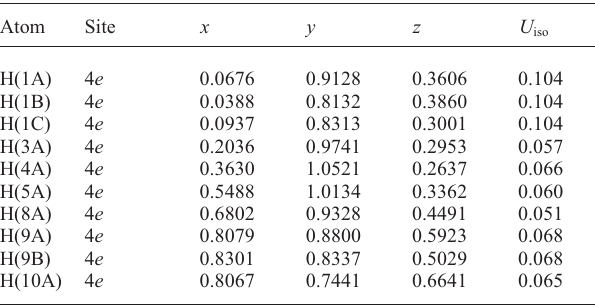
Table 2. Atomic coordinates and displacement parameters (in Å 2 )